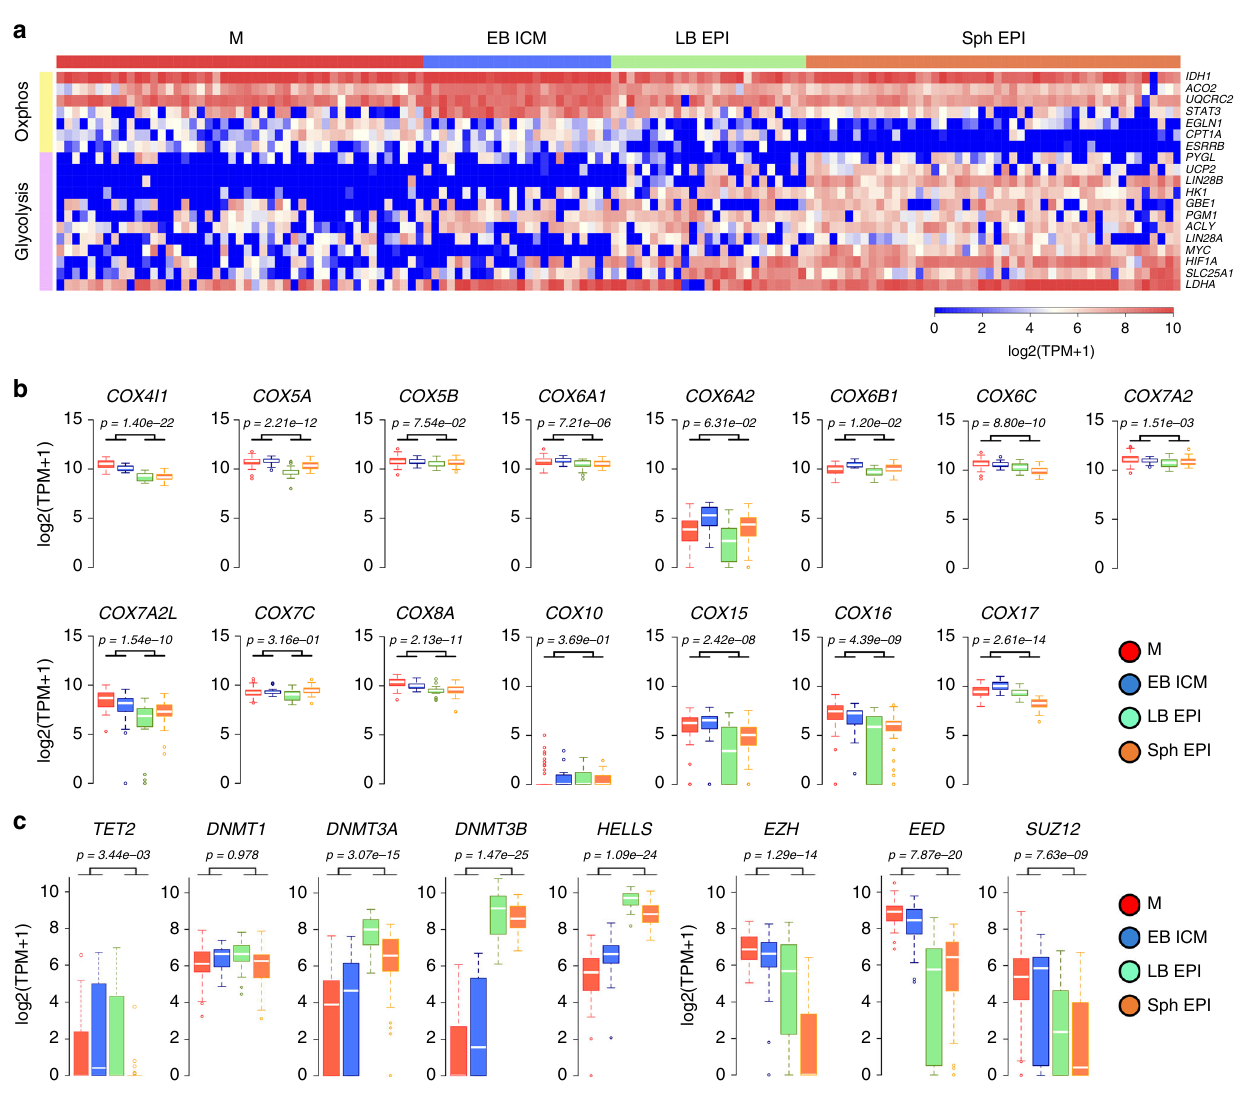
Fig. 7 Metabolic and epigenetic changes during progression of pluripotency. a Heat map of selected genes involved in OXPHOS and anaerobic glycolysis in pluripotent lineages. b Box plot showing expression of electron transport complex genes and c genes involved in epigenetic modi fi cations. Boxes show 25 – 75 percentile values and white line shows median gene expression ( p < 0.05 by two-sided Wilcoxon test). M: morula ( n = 47 cells), EB: early blastocyst ( n = 24 cells), LB: late blastocyst ( n = 25 cells), Sph: spherical embryo ( n = 48 cells), EPI: epiblast, ICM: inner cell